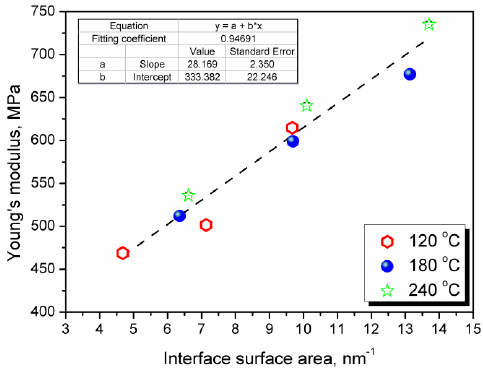
图 7 Figure 7. Young’s modulus as a function of interface surface area for prepared